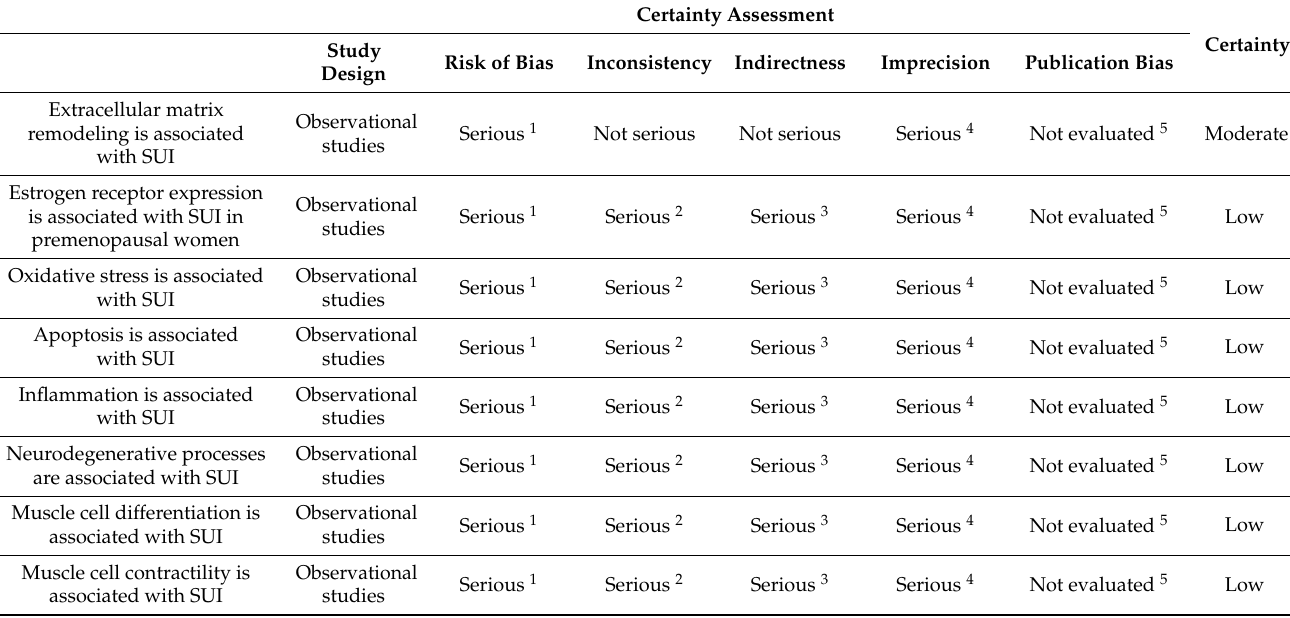
Table 3. Certainty of Evidence